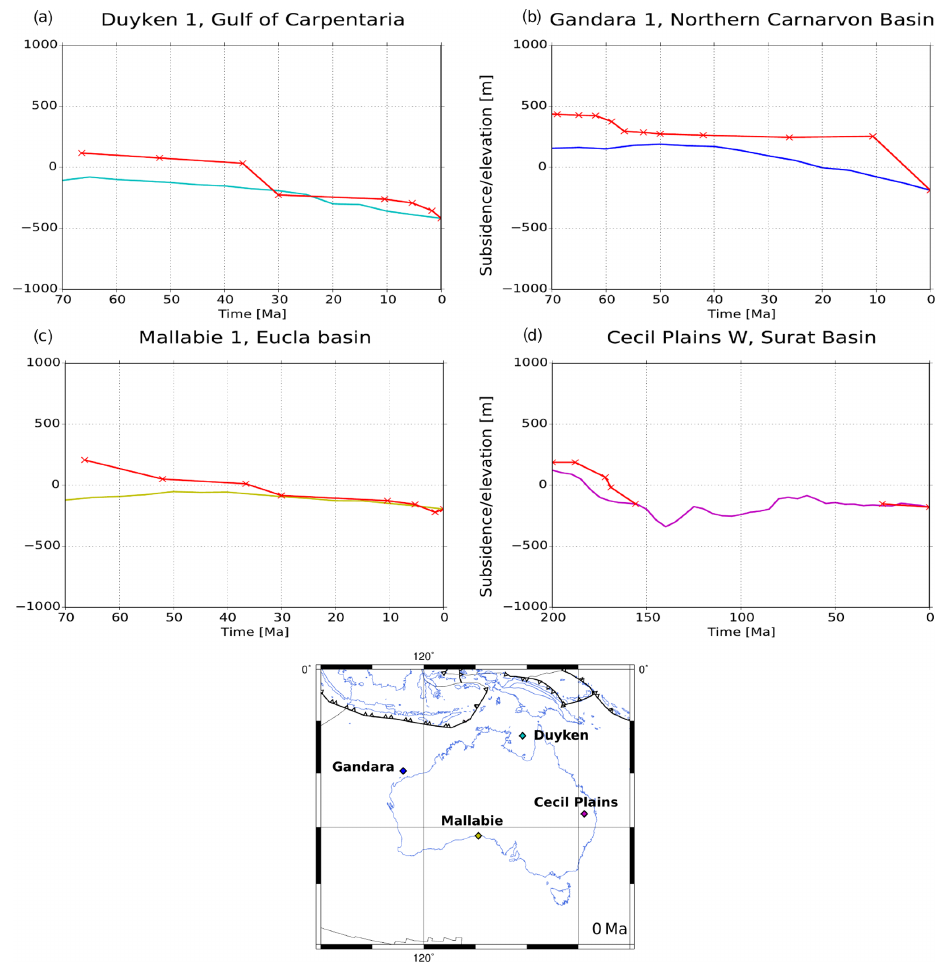
Figure 7. Tectonic subsidence curves for selected wells in Australia (red) compared to our model output (coloured). Well data curves (accordingly coloured) are offset to model elevation at present day.